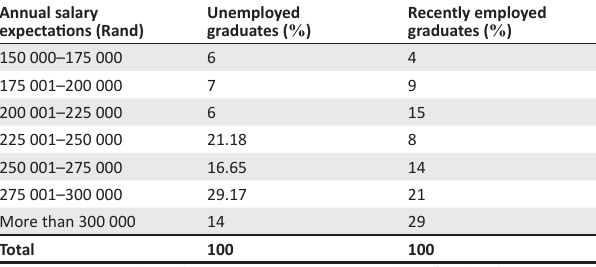
TABLE 4: Annual salary expectations. Annual salary expectations